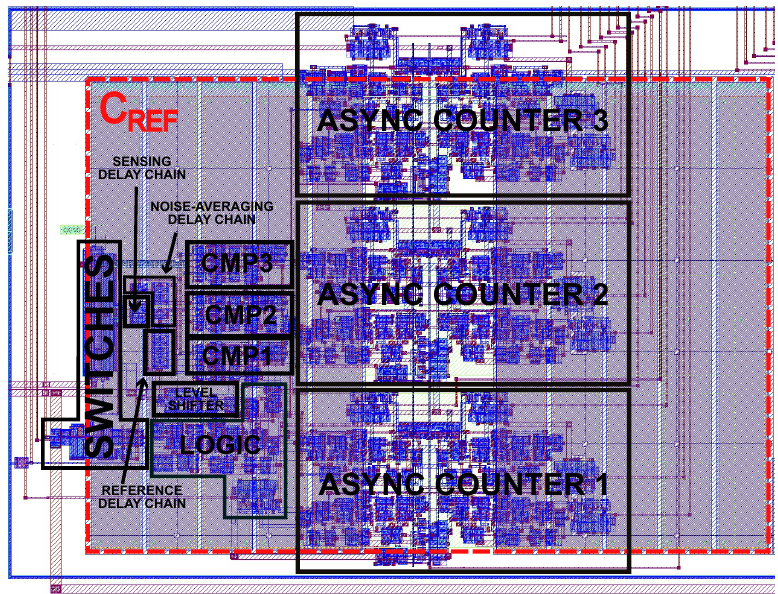
Figure 9. Layout of the CDC in a standard 0.18 µm 1-poly 6-metal-level-MIM CMOS technology. Bounding box size is 160µm (width) 120µm ×